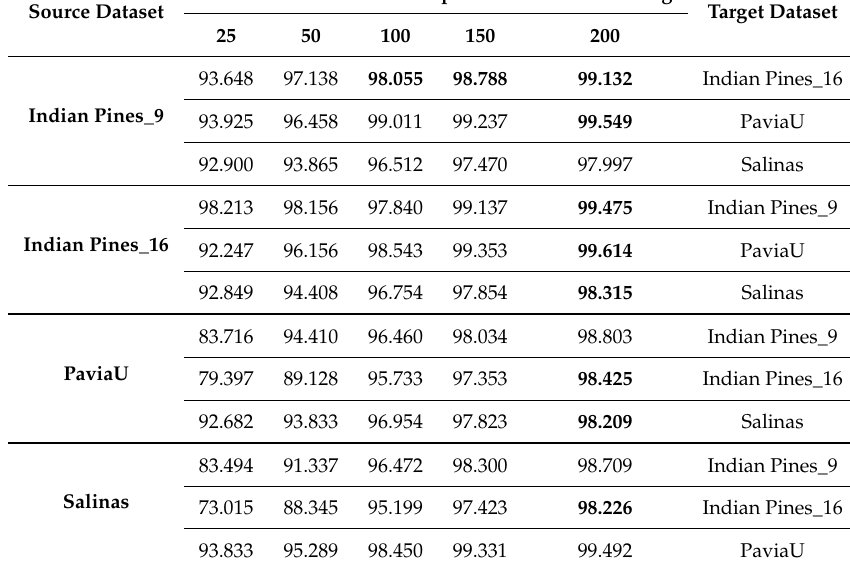
Table 12. OA (%) generated by the ASSP-SCNN-based transfer learning framework between the three HSI